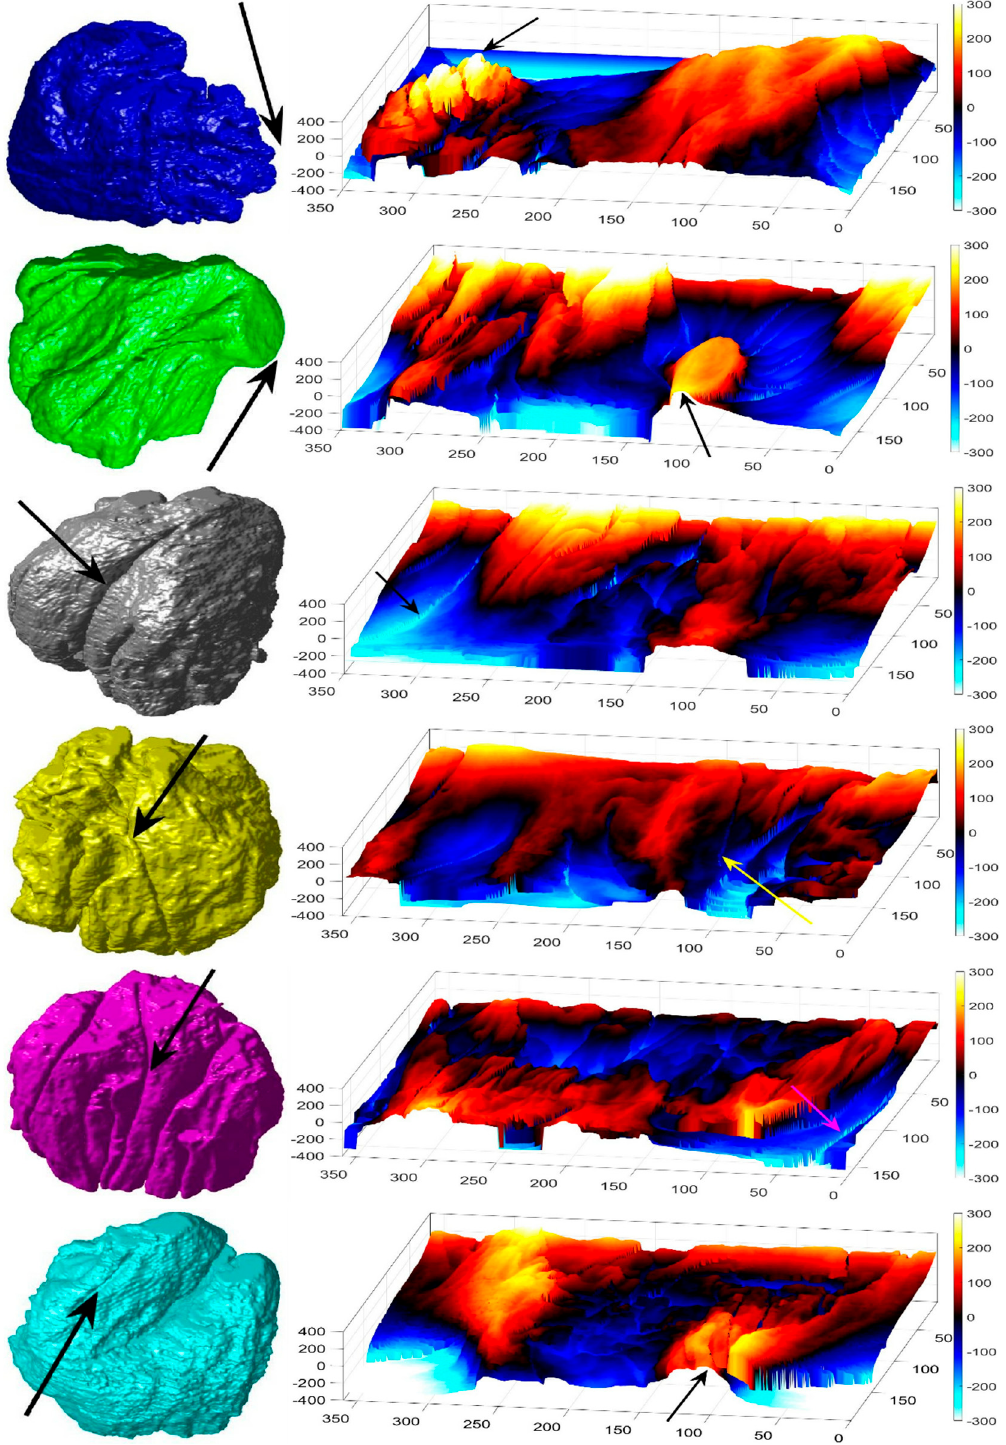
Figure 8. Final results of the automated segmentation displayed as rendered volumetric surfaces and modelling for six cells. Left: Segmentation results displayed as rendered volumetric surfaces for six different cells. In each cell, note the notches and invaginations, which may be relevant biological characteristics of the cells. Right: Surfaces corresponding to the distance from the nuclear envelope (NE) to a model spheroid. Arrows, in the last four rows, show notches that travel along the nuclei (grey, yellow, purple, and cyan cell).